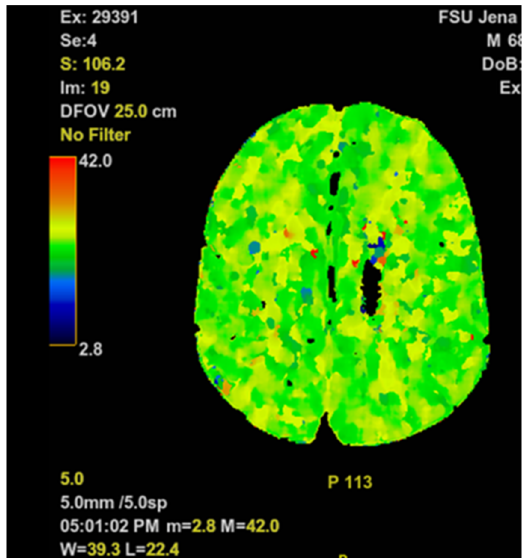
Figure 1. Representative cerebral perfusion scan slice of the head imaging study.